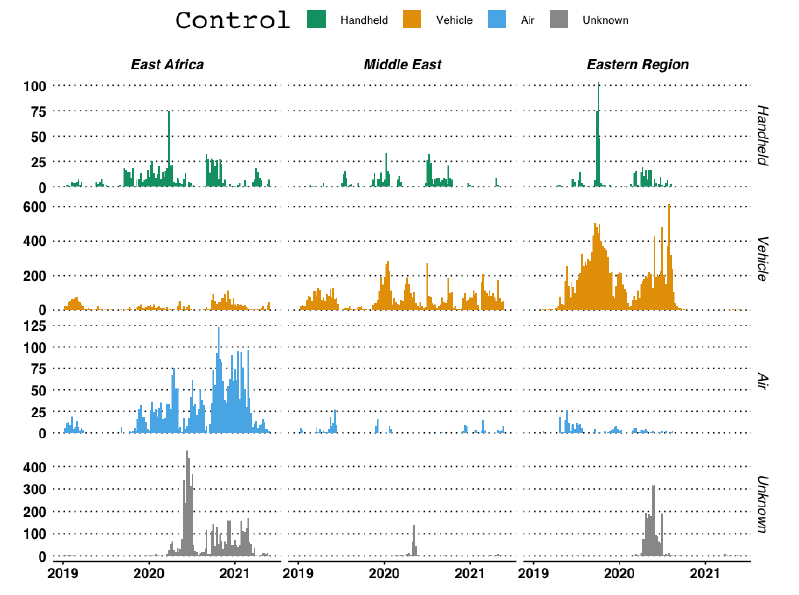
Figure 2. The weekly number of control operations. Control operations are categorised according to region: East Africa, the Middle East and the Eastern Region. Data from [24] (Locust